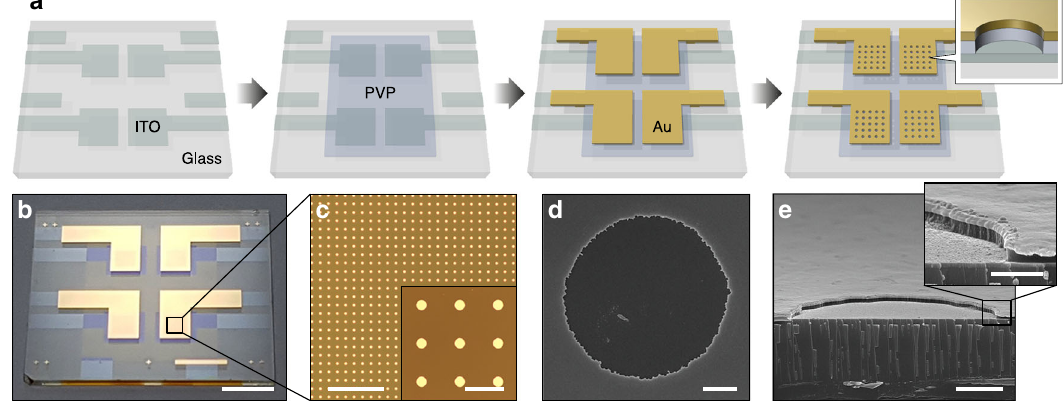
Fig. 2 Fabrication of VNE arrays. a Schematics of the fabrication process. b – e A VNE sample ( b ), micrographs of a VNE array ( c ), top-view ( d ), and cross- sectional view SEM images ( e ) of a VNE single unit. Scale bars, 5 mm ( b ), 200 μ m ( c ), 30 μ m (inset in c ), 2 μ m ( d , e ), and 500 nm (inset in e